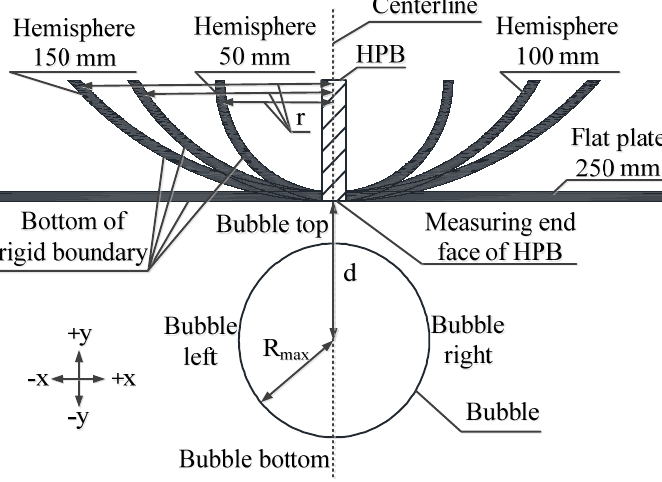
Figure 4. The cross-sectional geometric details of the rigid boundary and description of the directions.